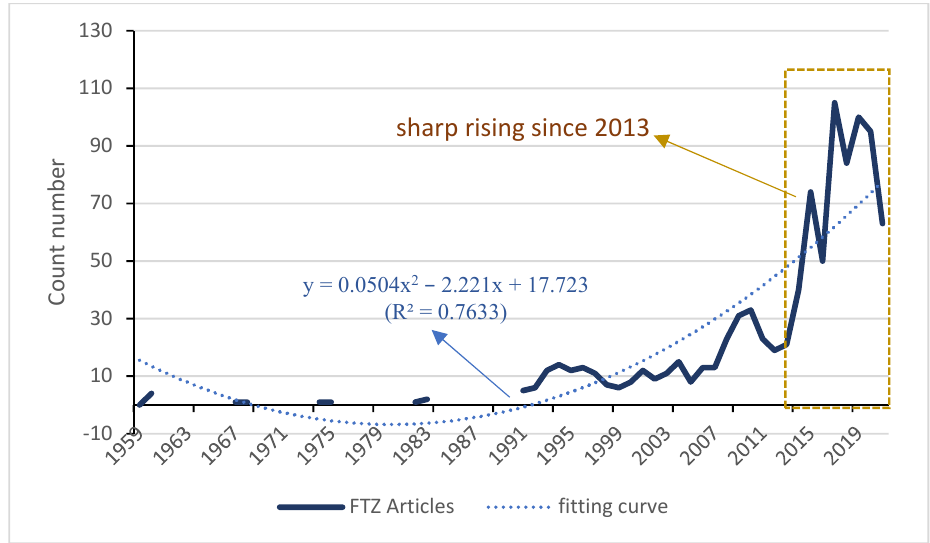
Figure 5. The annual count number of FTZ articles.